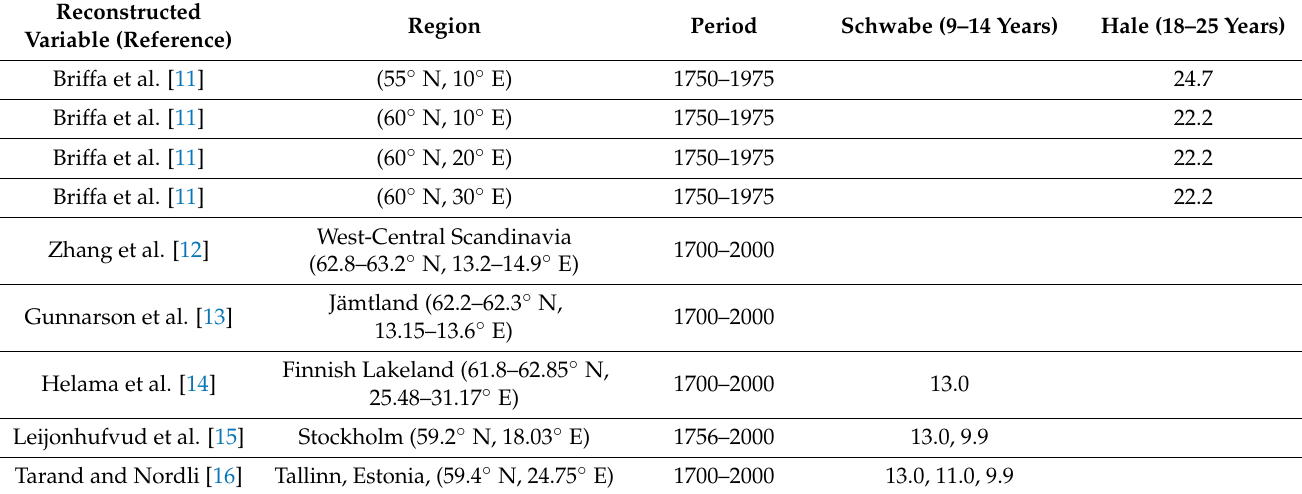
Table 2. Peaks of Fourier spectra of temperature reconstructions significant at more than 0.95 CI (1700–2000 AD).